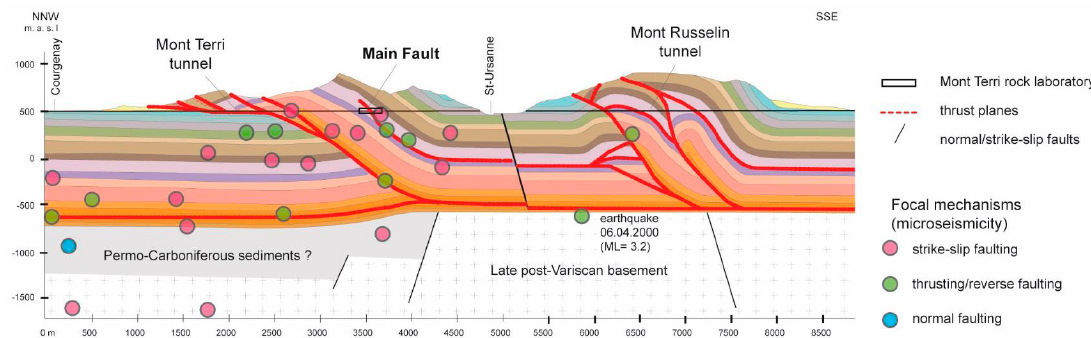
Figure 1. Geological cross-section along the Mont Terri Underground Research Laboratory (adapted from [26]).